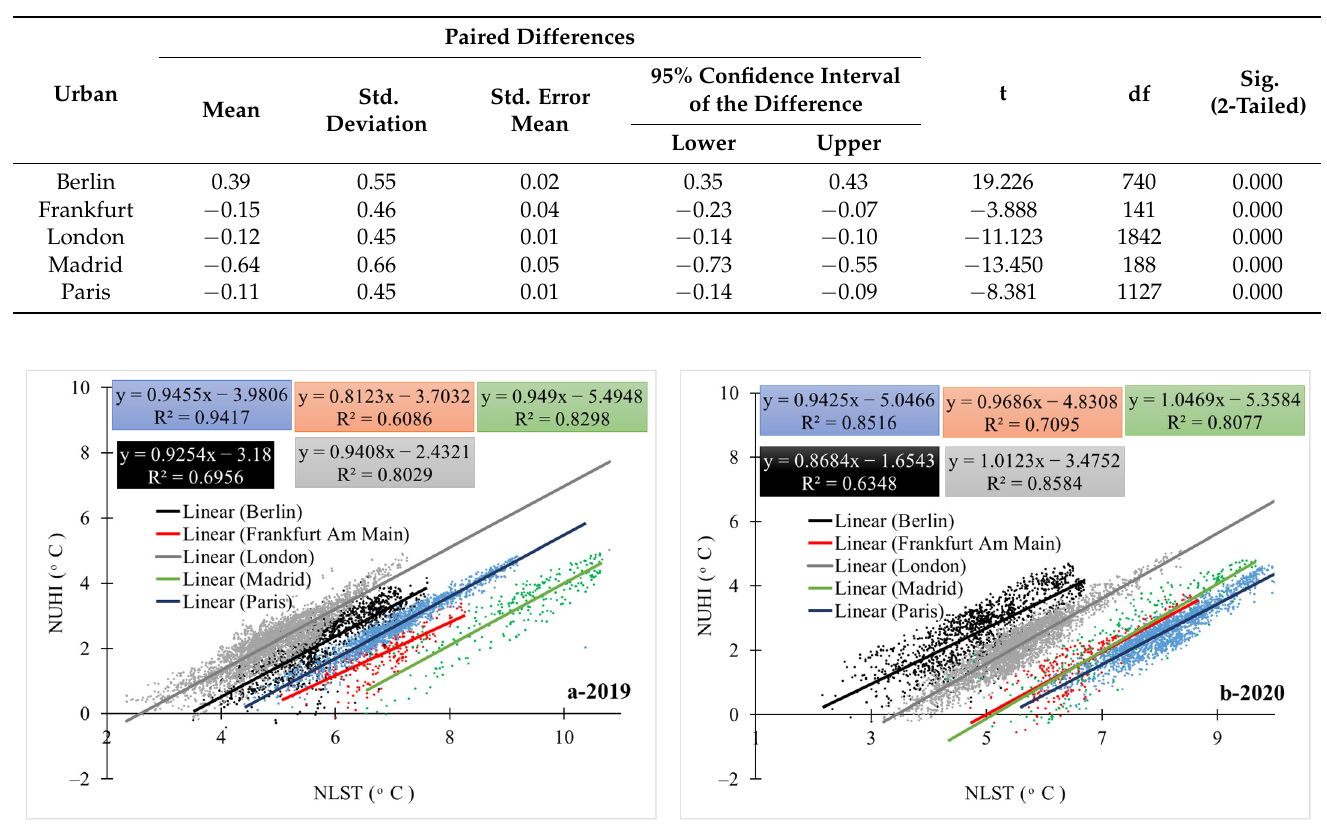
Figure 10. ( a-2019 ) relationship between NLST and NUHI in the studied cities 2019. ( b-2020 ) relationship between NLST and NUHI in the studied cities 2020. Table 3. Correlation between NUHI and NLST in the studied cities during 2019 and 2020.